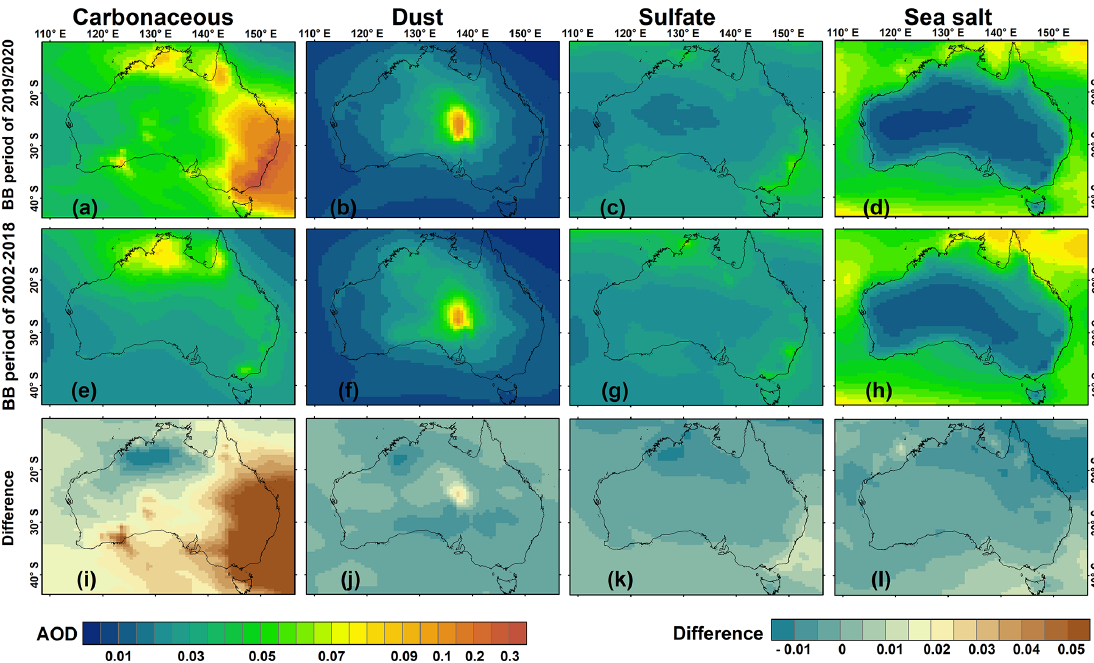
Figure 14. Spatial distributions of carbonaceous, dust, sulfate, and sea salt AODs from MERRA-2 during the BB period of 2019/2020 (first row), the BB period of 2002–2018 (second row), and the differences between the two periods (third row) over Australia.